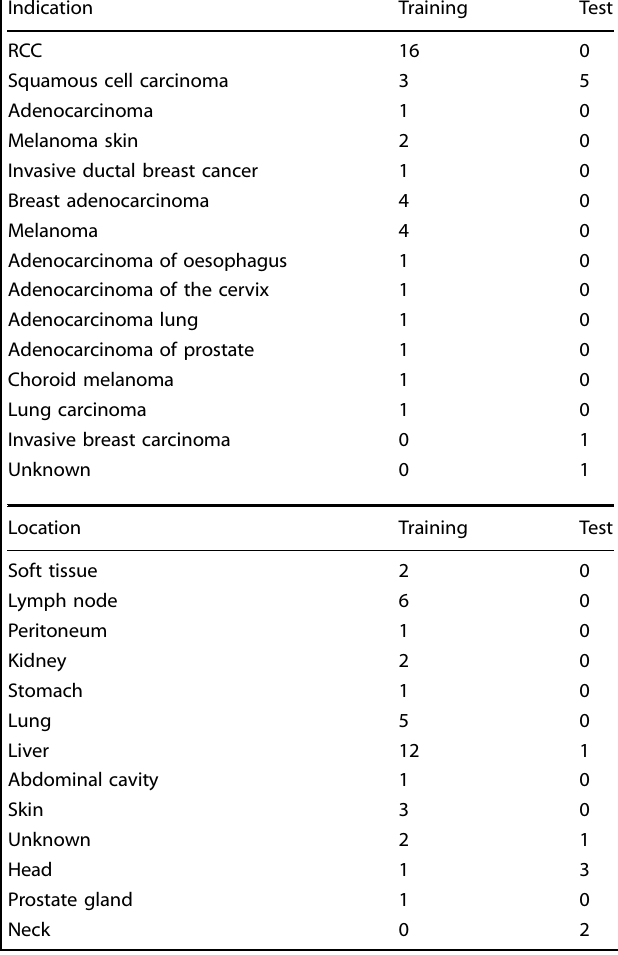
Table 2. Indications and biopsy locations are represented in the